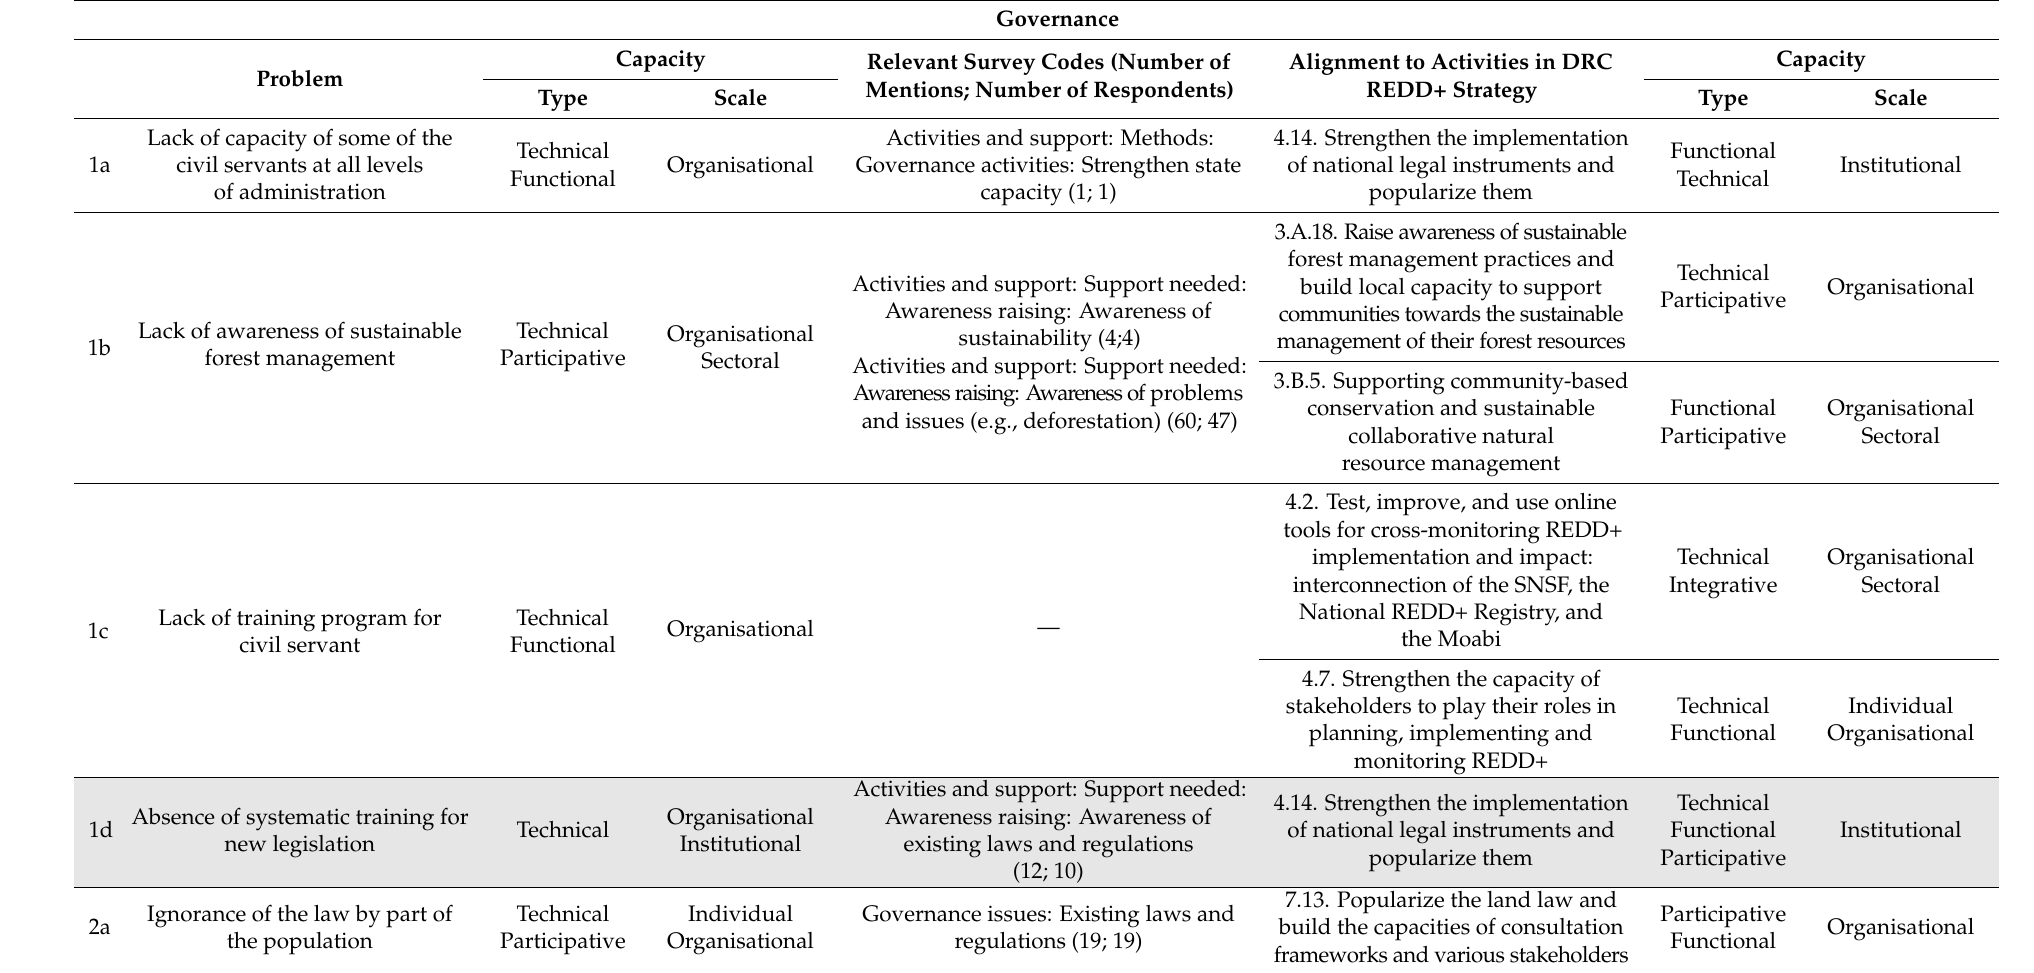
Table 2. Governance and Legal Capacity Issues Identified in É quateur Provincial Government Stakeholder Workshop and Aligned DRC REDD+ Strategy Actions. Highlighted issues in grey are proximal issues from the bottom of problem tree